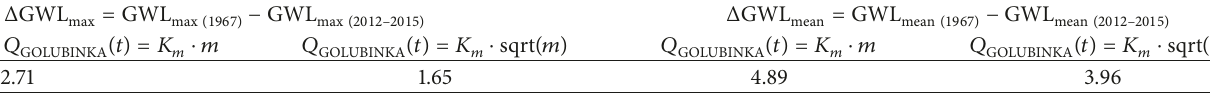
Table 1: Difference between calculated (2012–2015) and measured (1967) values of GWL max and GWL mean . Δ GWL = GWL − GWL max max (1967) max (2012 – 2015)